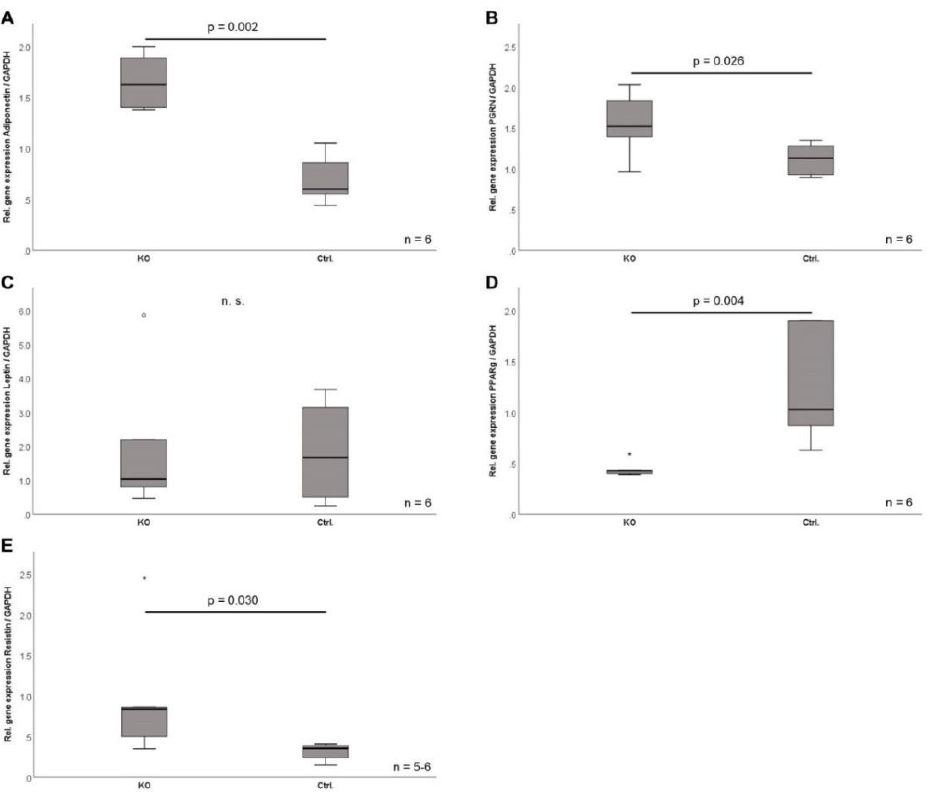
Figure 5. Gene expression analysis of adipokines in primary adipocytes. Preadipocytes ( n = 6) were isolated from intra-abdominal adipose tissue of CTRP-3 KO mice and littermate control animals and were differentiated into mature adipocytes over 9 days of a hormonally induced differentiation program. Gene expression levels of adipokines and of the adipocyte- specific transcription factor PPAR γ were determined in fully differentiated cells at day 9 by real-time PCR and were normalized to GAPDH mRNA levels. GAPDH , glyceraldehyde-3-phosphate dehydrogenase; PGRN , progranulin; PPAR γ , peroxisome proliferator-activated receptor γ . ◦ ,